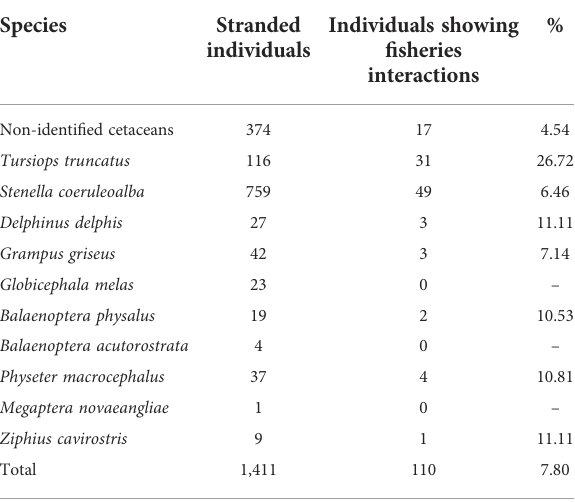
TABLE 3 Number of cetacean individuals stranded on the Valencian Community coast between 1990 and 2020. Individuals showing fi sheries ’ interaction evidence are given per species, with its associated percentage (%) calculated according to the total strandings of each